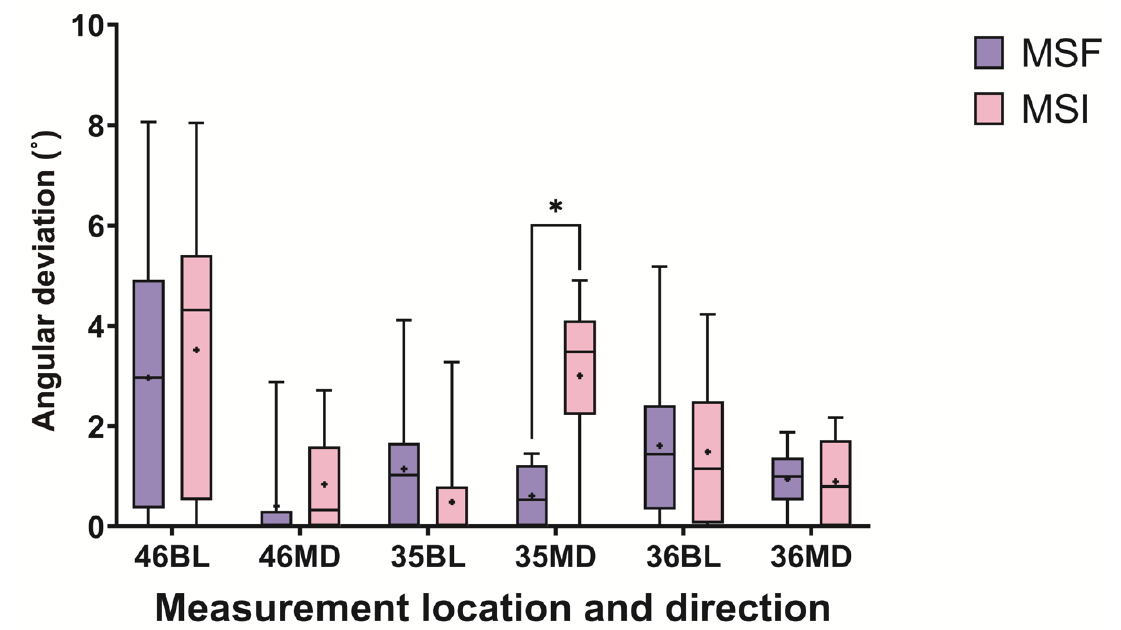
Figure 4. Preoperative and postoperative weight differences of the MSF and MSI groups. No sta- tistically significant differences were observed. Data are expressed as mean ± standard deviations.